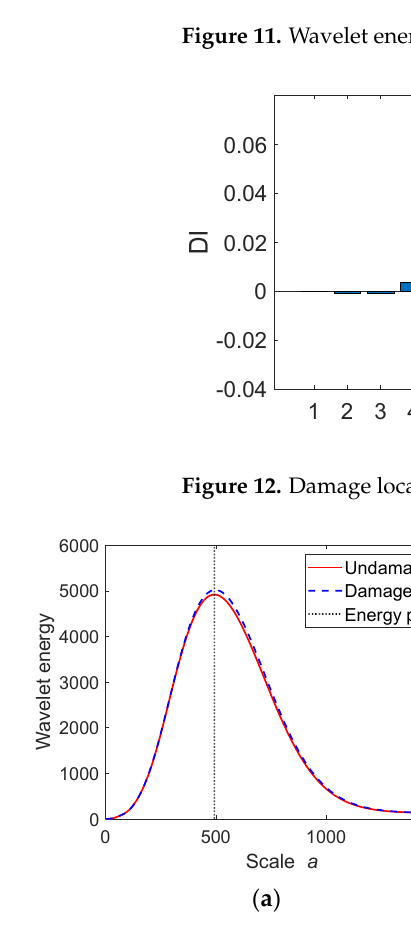
Figure 13. Bridge damage identification. ( a ) wavelet energy; ( b ) damage index .